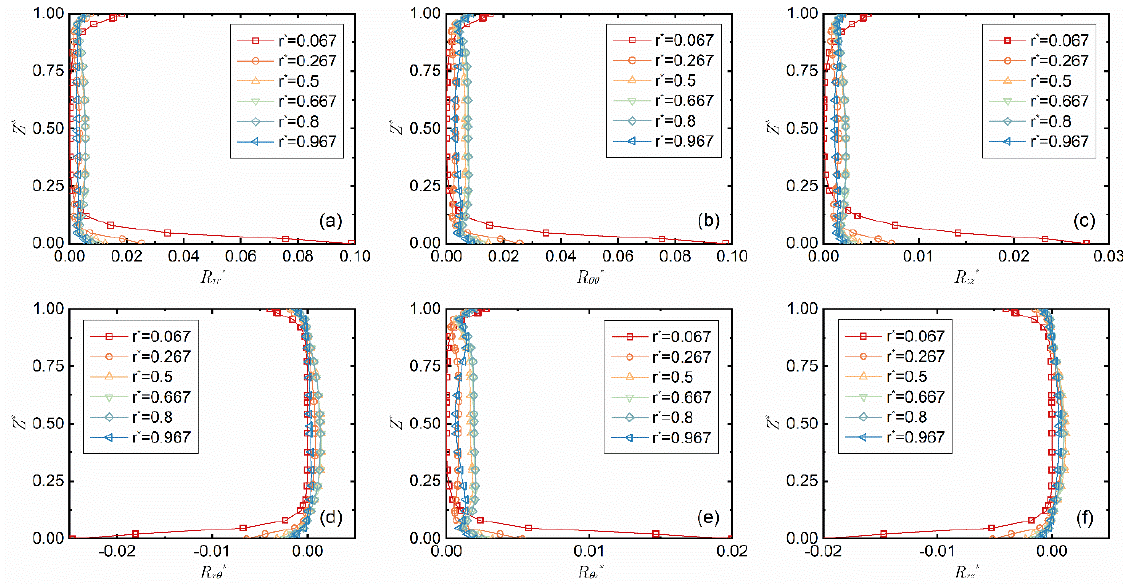
Figure 5. Change of the six components of the Reynolds stress tensor ( a – f ) with the radial position r * when Re = 7.02 × 10 4 and G =